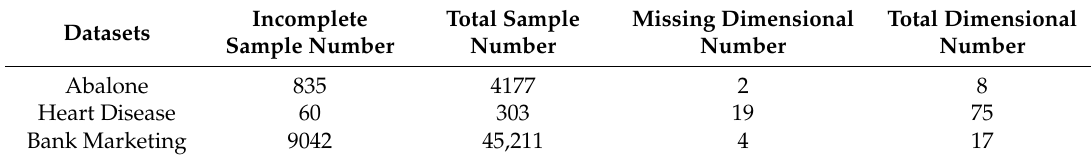
Table 3. Detail information of UCI standard